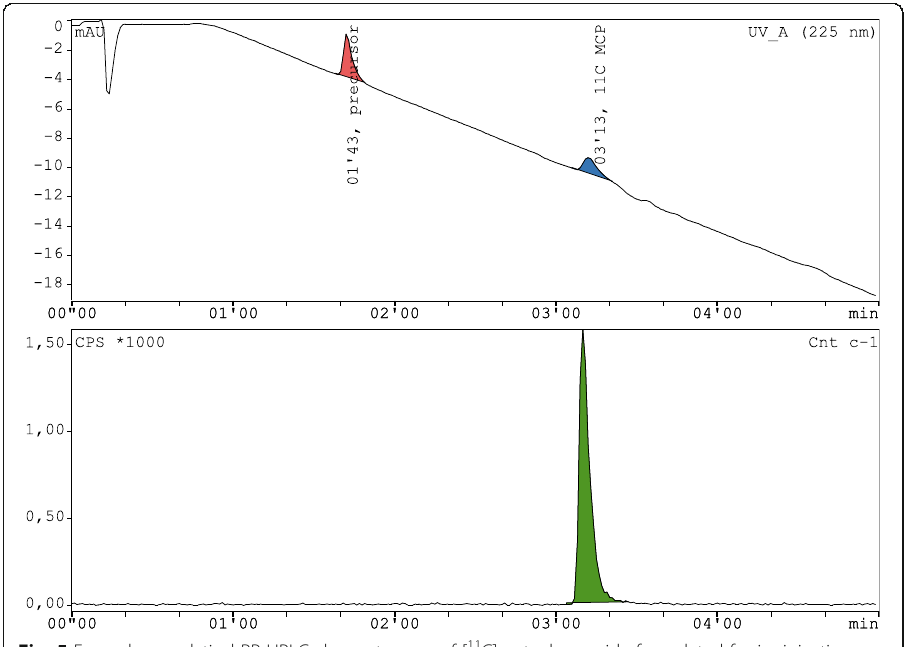
Fig. 5 Exemplary analytical RP-HPLC chromatogram of [ 11 C]metoclopramide formulated for i.v. injection including the signal of the UV-detector (225 nm, upper channel) and radio-detector (lower